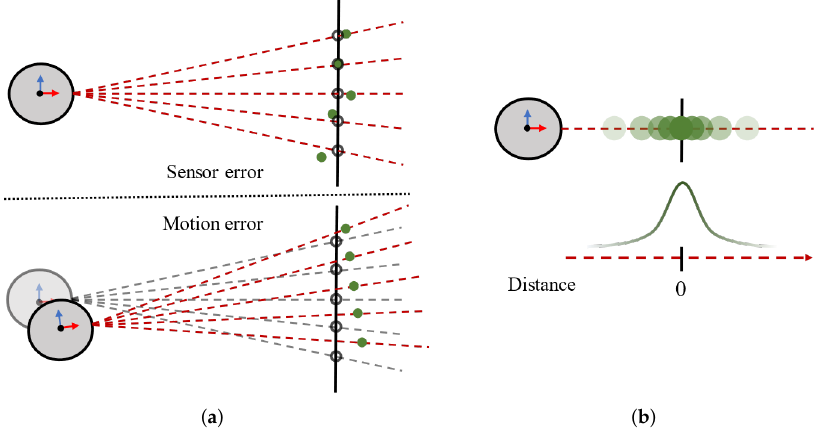
Figure 2. Point clouds noise models and point clouds distribution assumption. Green-filled dots are reconstructed point clouds. Black-empty dots represent ideal measurements. ( a ) Two types of noise models. The upper example shows the noise model with sensor error. Point clouds acquired by LiDAR sensor are not aligned owing to sensor error. The lower example shows the noise model with motion error. Point clouds acquired from true position of LiDAR sensor (gray) are shifted owing to the position of LiDAR sensor with motion error (thick circle). ( b ) Gaussian assumption of point clouds distribution generated by noise model shown in ( a